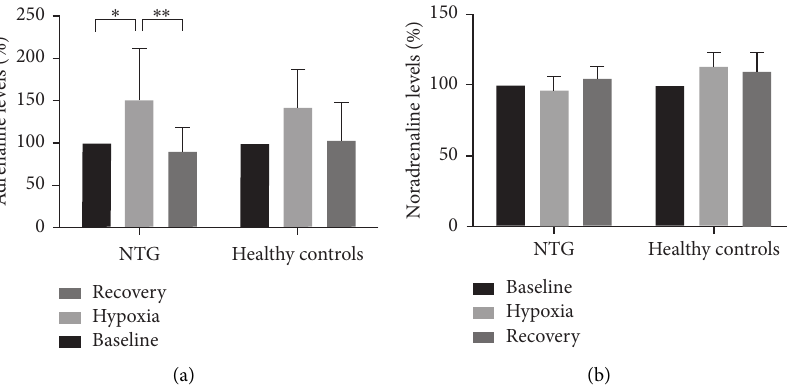
Figure 4: A relative increase in peripheral blood adrenaline was seen during hypoxia for patients with NTG. Patients with NTG also showed relative decrease in adrenaline during recovery. No significant changes were seen for age-matched healthy controls. No significant dif- ferences or changes were seen for noradrenaline (statistics: two-way ANOVA, Tukey’s multiple comparisons